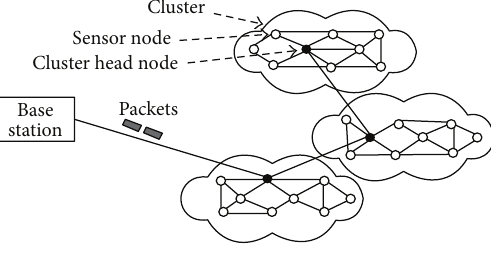
Figure 1: Wireless sensor